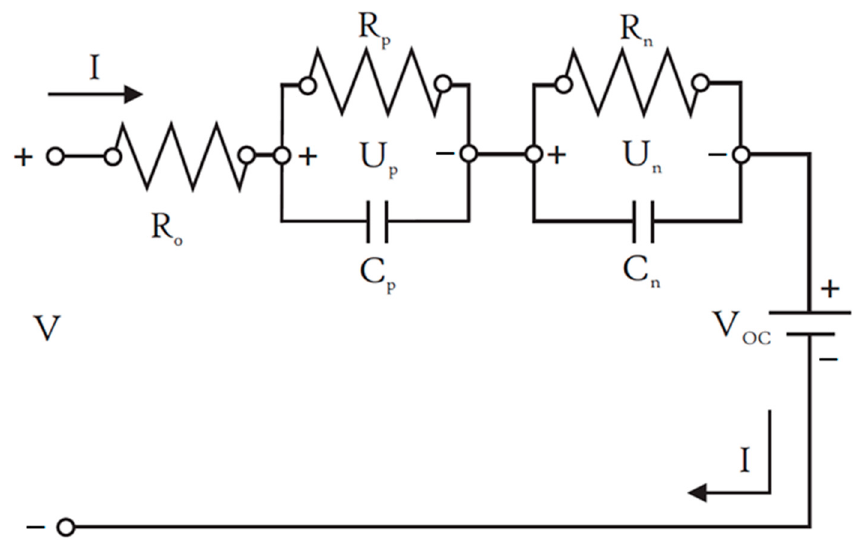
Figure 3. Electric circuit model diagram.